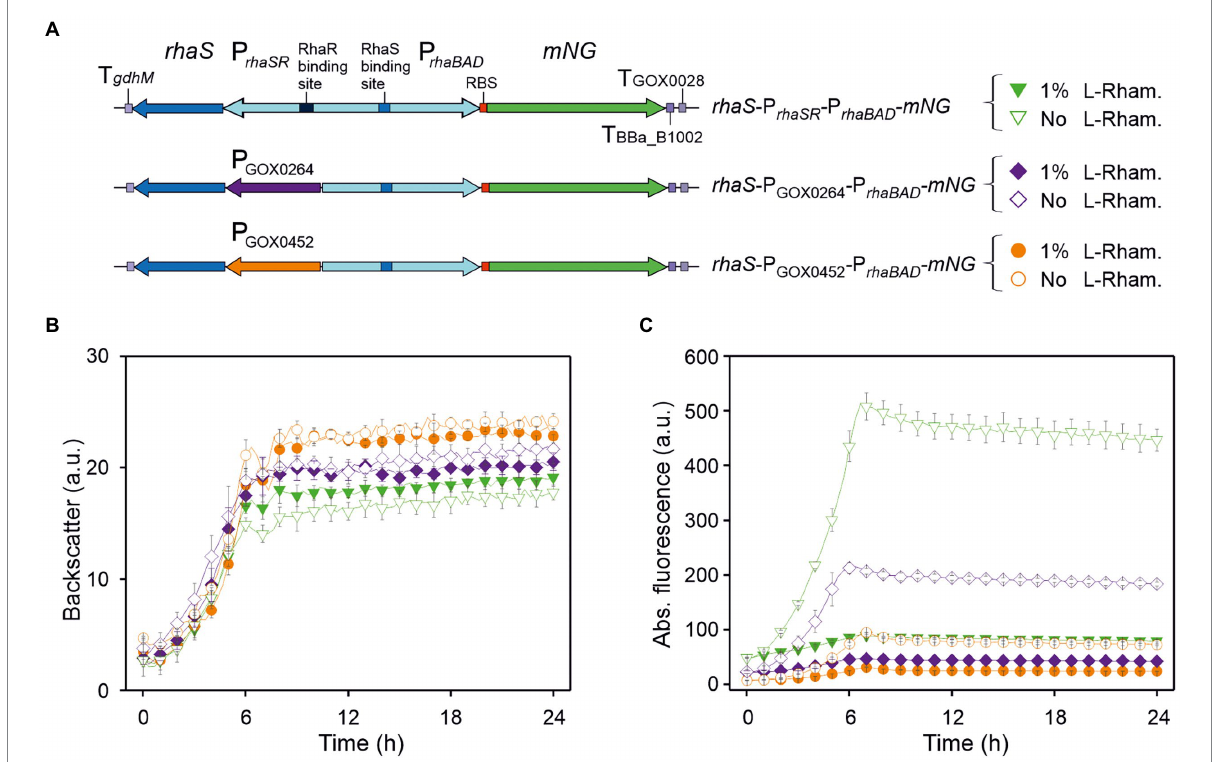
FIGURE 2 Performance of P rhaBAD -derived mNG expression in dependence of rhaS expression and presence of l -rhamnose. (A) Schematic illustration of the plasmid variants for constitutive expression of rhaS from the strong and moderate G. oxydans promoters P GOX0264 and P GOX0452 . T gdhM : terminator sequence of gdhM (GOX0265); T GOX0028 : terminator sequence of GOX0028. RBS: 5 ′ -AGGAGA inserted in the 3 ′ region of P rhaBAD upstream from mNG . (B) Growth in d -mannitol medium according to backscatter and (C) absolute mNG fluorescence of G. oxydans 621H carrying either plasmid pBBR1MCS-5- rhaS -P rhaSR -P rhaBAD - mNG , or pBBR1MCS-5- rhaS -P GOX0264 -P rhaBAD - mNG , or pBBR1MCS-5- rhaS -P GOX0452 -P rhaBAD - mNG . Repression of mNG expression from P rhaBAD was tested with 1% (w/v) l -rhamnose. Data represent mean values and standard deviation from two biological replicates (clones) with three technical replicates each. BioLector settings: backscatter gain 20, fluorescence gain